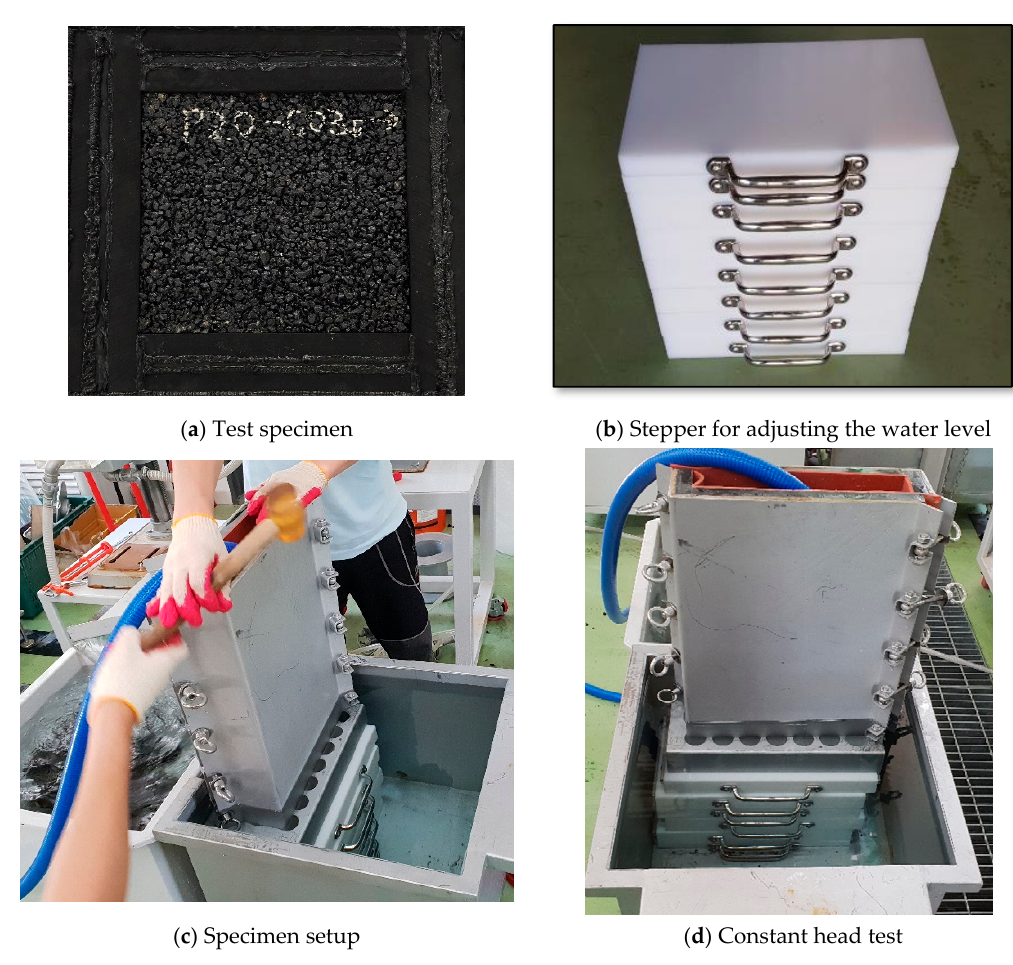
Figure 3. Horizontal permeability test for porous asphalt specimens (after Ahn et al. [23] ).